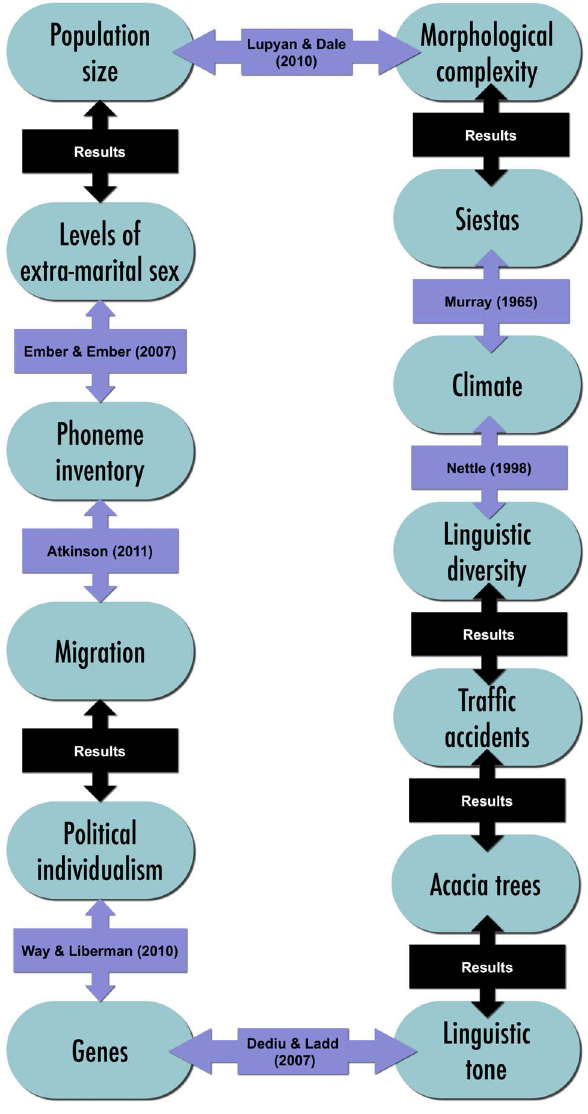
Figure 3. Chains of spurious correlations. Statistical links can be found between these cultural traits. Links from previous studies are labelled with the authors’ names. The links from the results section of the current study are labelled ‘results’.